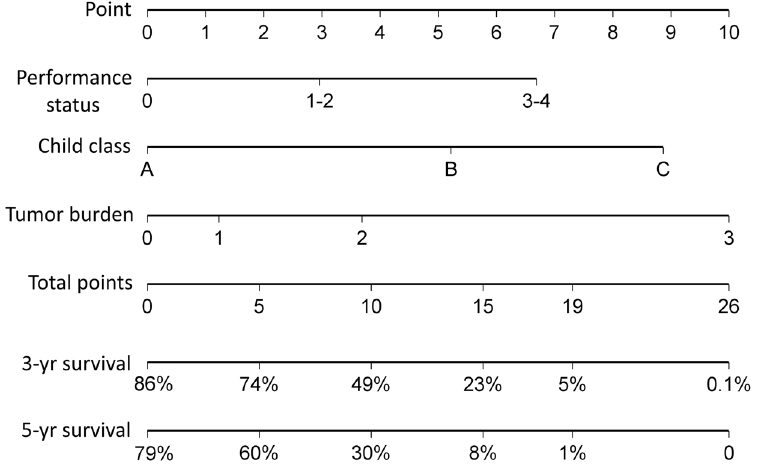
Figure 5. The nomogram of original BCLC system from ref. 3. Three parameters, tumor burden, cirrhosis and PS are used in the nomogram to generate nomogram point between 0–26.